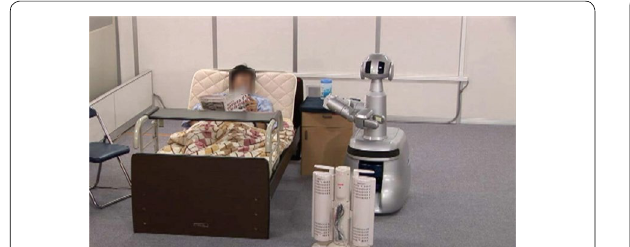
Fig. 6 Examples of prototype tests in [19]. a Grasping bottle, b Support of